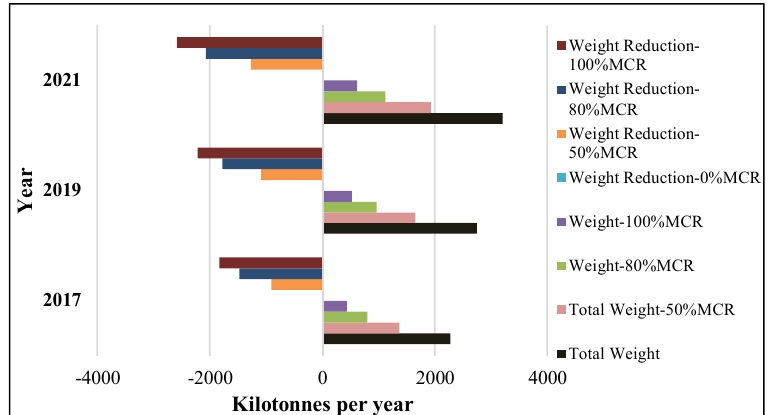
Figure 6. The total estimated weight of the biodegradable wastes before and after moisture reduction.